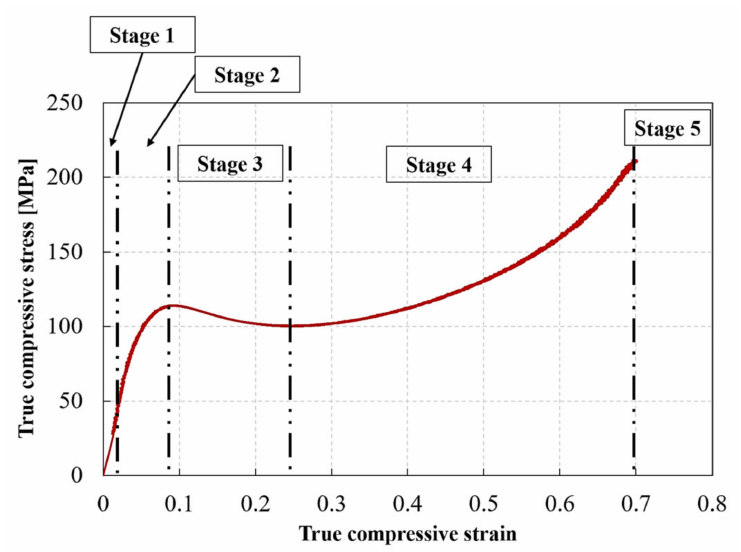
Figure 8. Stages of deformation of a silica nanoparticle sample (0.1% NPsNF) in compression.